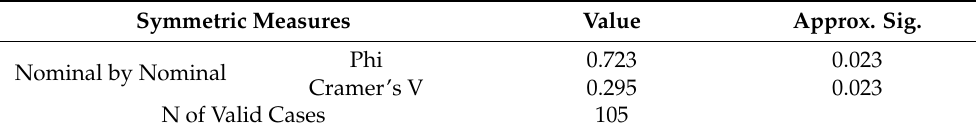
Table 9. Evaluation of the